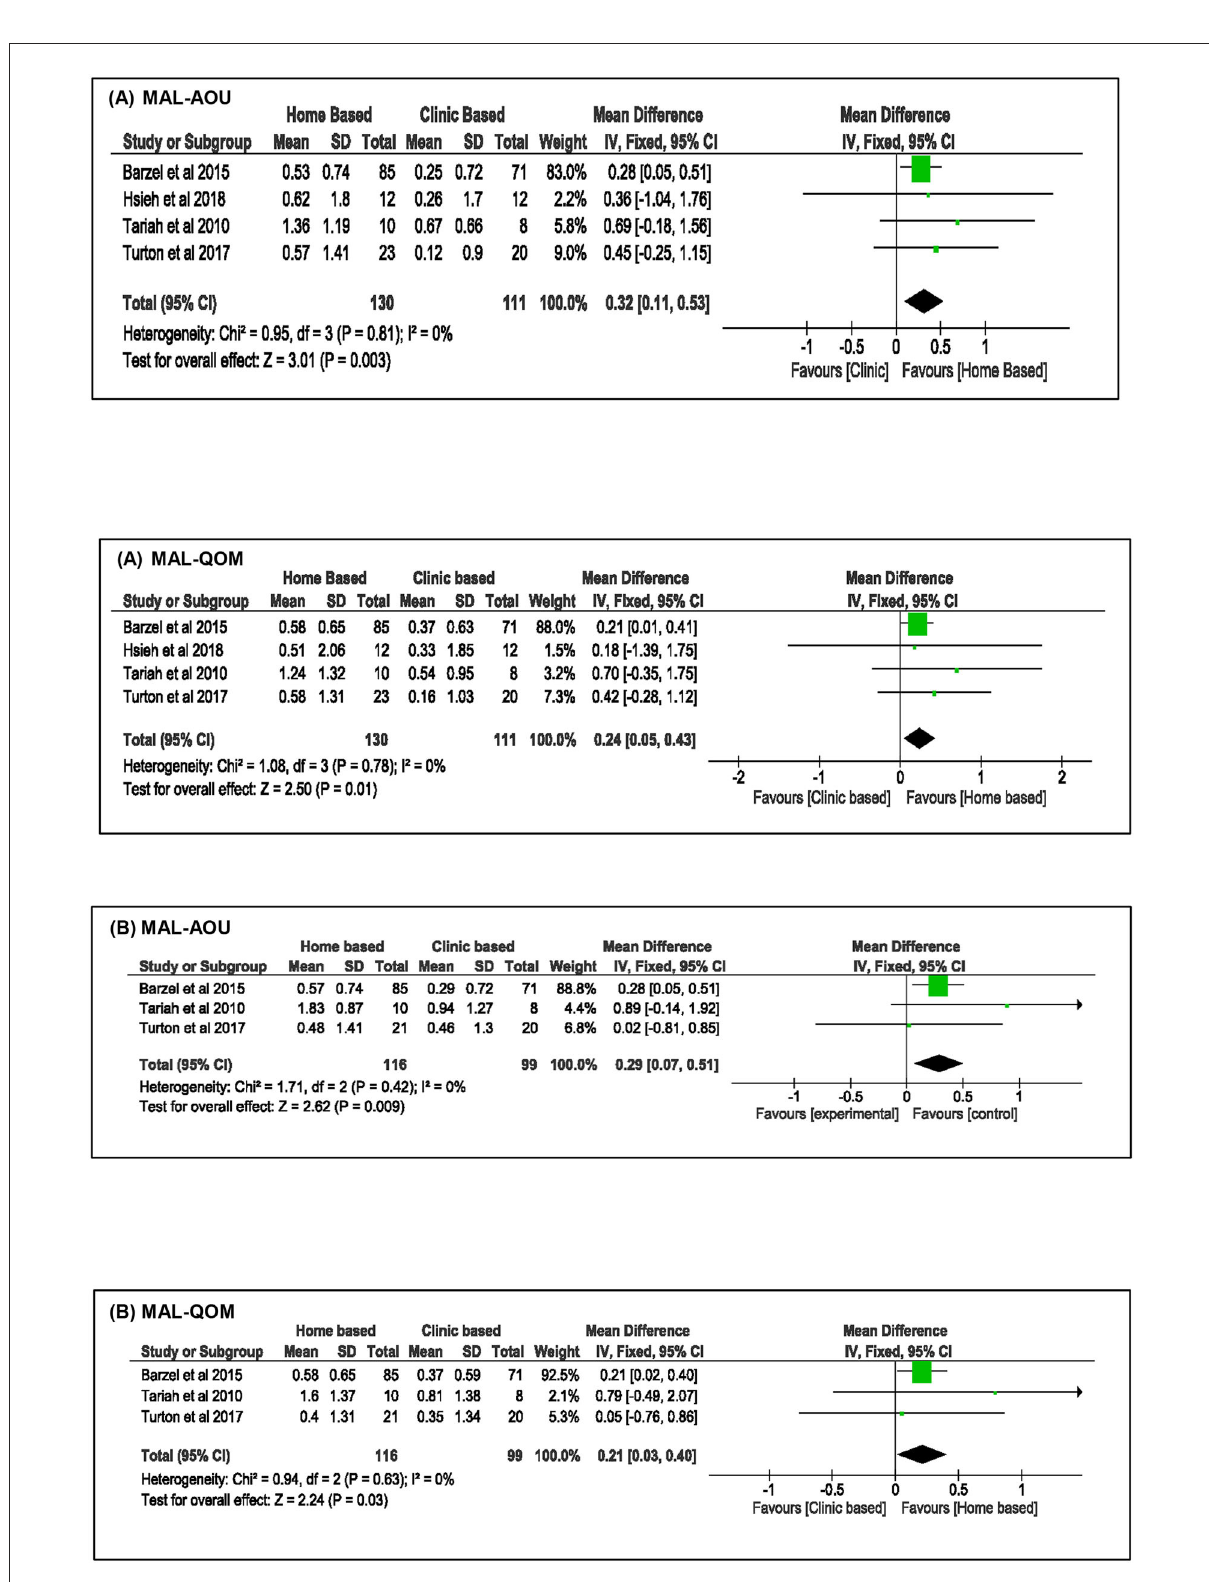
FIGURE3 Comparison of the effect of home-based intervention and conventional therapy on MAL outcomes (A) mean difference (MD) immediately after the treatment. (B) Mean difference (MD) at